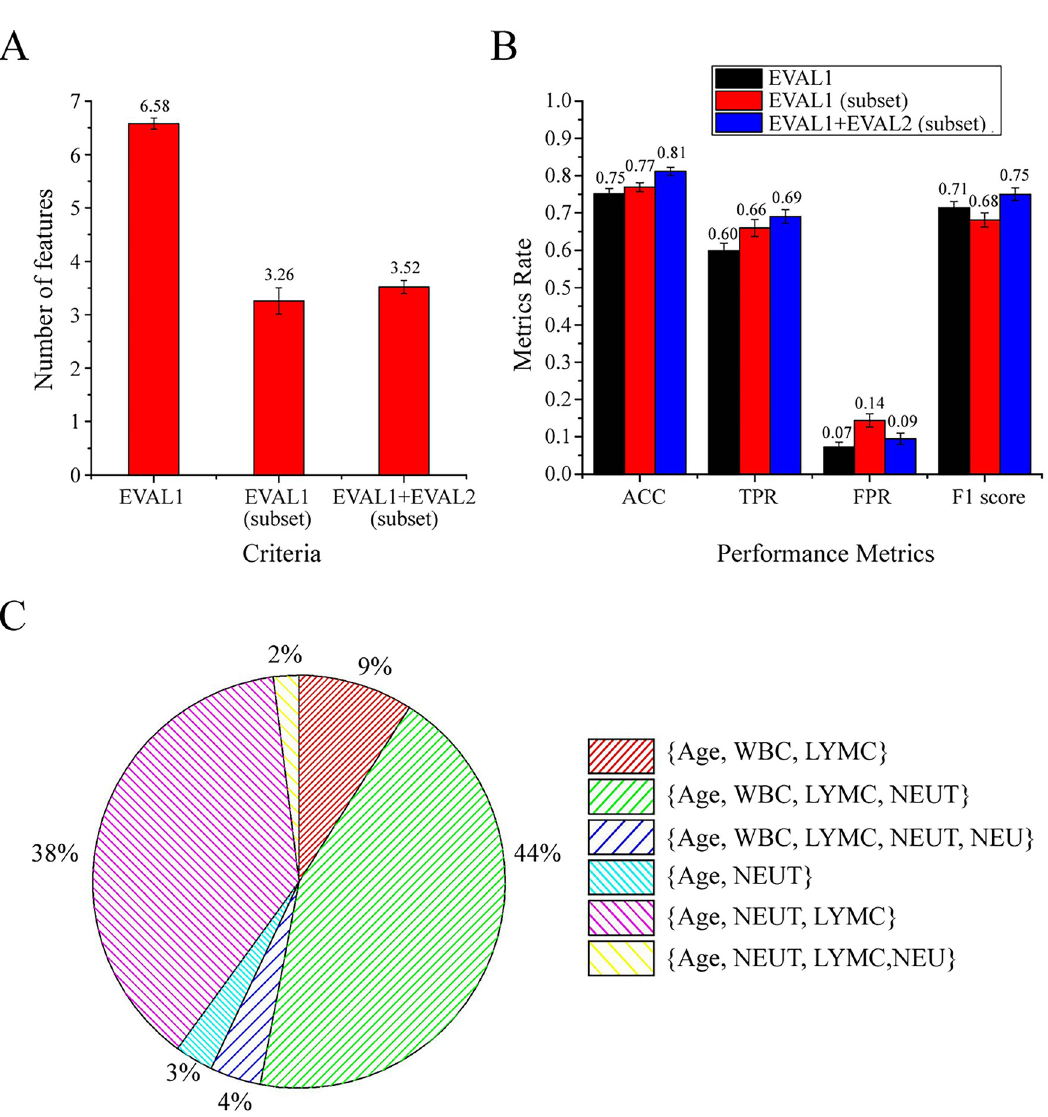
Fig 4. The subset of features selected by the MCDM algorithm to predict the severity of COVID-19. Data set was divided 100 times (80% training set and 20% test set) and repeatedly run the algorithm to test the stability of the algorithm and observe the influence of the dataset uncertainty on feature selection. (A). the average number of features selected by 3 different criteria. EVAL1: The correlation between input features x 2 X and output features y 2 Y , R [ x,y ] or R [ y,x ]; EVAL2: The correlation between input features x 2 X and labeled features v 2 L , R [ x,v ] or R [ v,x ]; Subset: The optimal input feature subset. Error bars represents 95% CI. (B). The metrics (ACC, TPR, FPR and F1 score) of 3 different criteria. Error bars represents 95% CI. (C). Different feature selection rates of EVAL1+ EVAL2